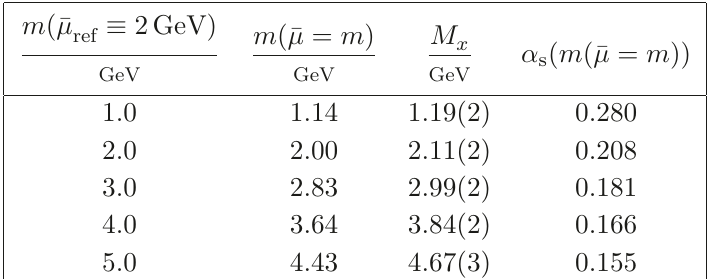
f = 0). We have used has been x = 0 . 47(1)fm [50], whereby Λ 253 MeV (a recent analysis yields 0 MS ≃ ) = 1 GeV is close to the value ref M / 2 1 . 49 GeV, whereas m (¯ µ ) = 5 GeV is close η c ref 1S ≡ ≈ 4 . 66 GeV, however these expectations are 1S ≈